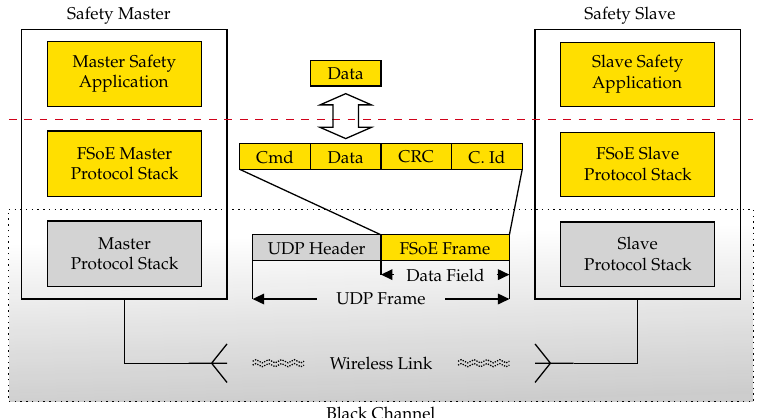
Figure 3. Implementation of the FSoE Protocol